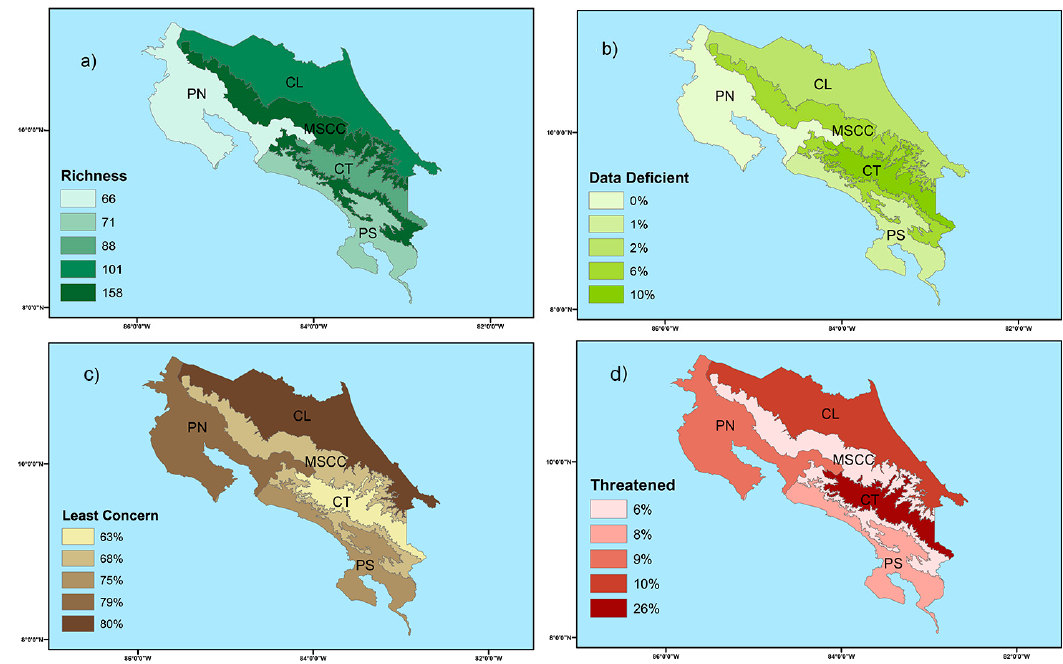
Figure 2. Map of Costa Rica showing ( a ) amphibian species richness for each herpetological province and percentage of amphibian species classified as ( b ) data deficient, ( c ) least concerned, and ( d